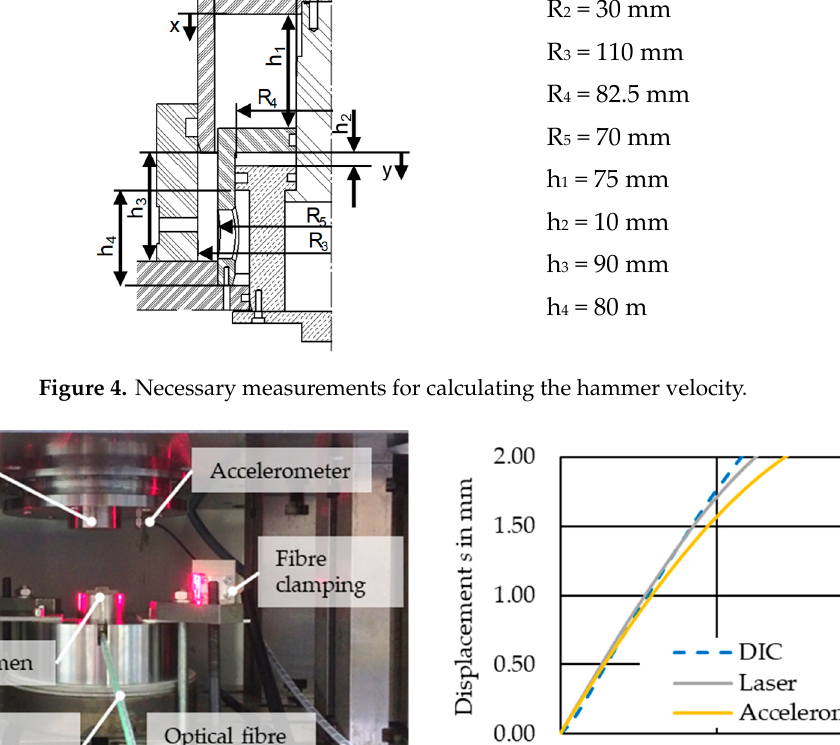
Figure 6. Image sequence for DIC taken during a shear test.